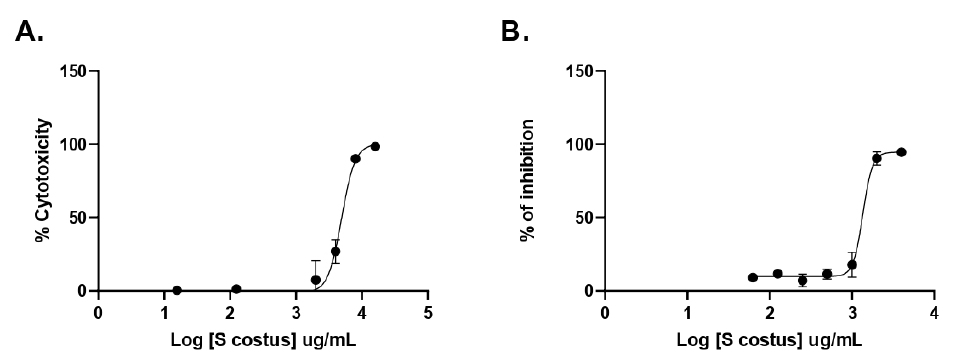
Figure 6. Antiherpetic activity and cytotoxicity of Saussurea costus aqueous extract. ( A ) Vero cells were incubated with increasing concentrations of the extract, and after 72 h, the cytotoxicity was measured as described in Section 2. ( B ) Vero cells were infected at MOI 1.5 with HSV-1 and incubated with increasing concentrations of the extract. After 72 h, the virus genome production was quantitated in the supernatant by qPCR. The % of inhibition was determined as the ratio between treated and untreated infected cells. Data are expressed as mean +/− SD for n = 2.